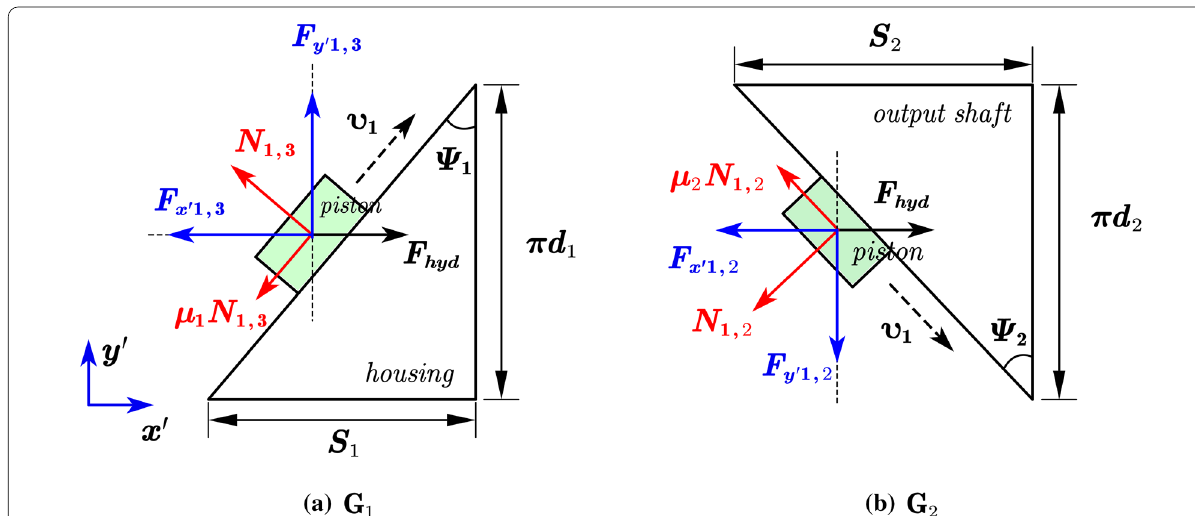
Figure 4 Mechanical analysis of S 1 and S 2 helical pairs